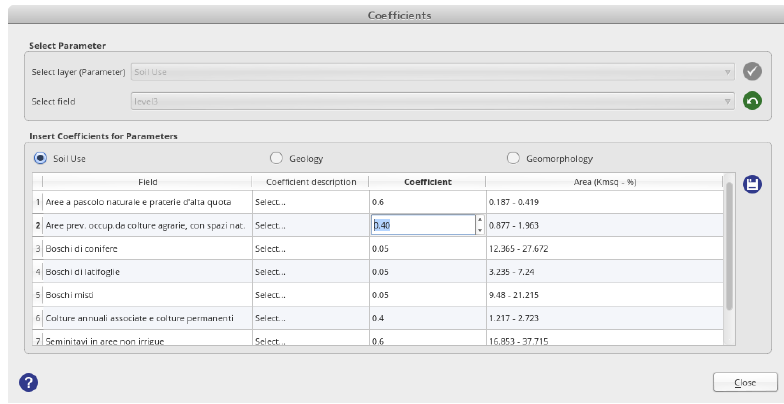
Figure 3. Graphical User Interface of stage 2. The user can select a preloaded coefficient value from Coefficient description column or insert manually a value in the Coefficient column.